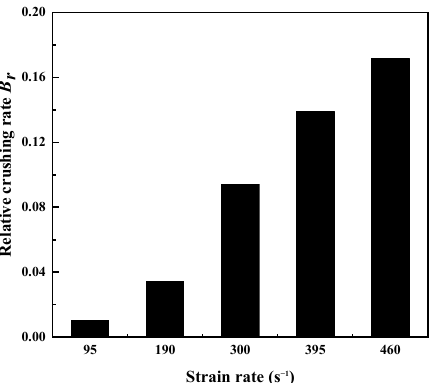
Figure 14. Relative crushing rate of dry sand specimens with initial relative density of 0.9 for different strain rates.